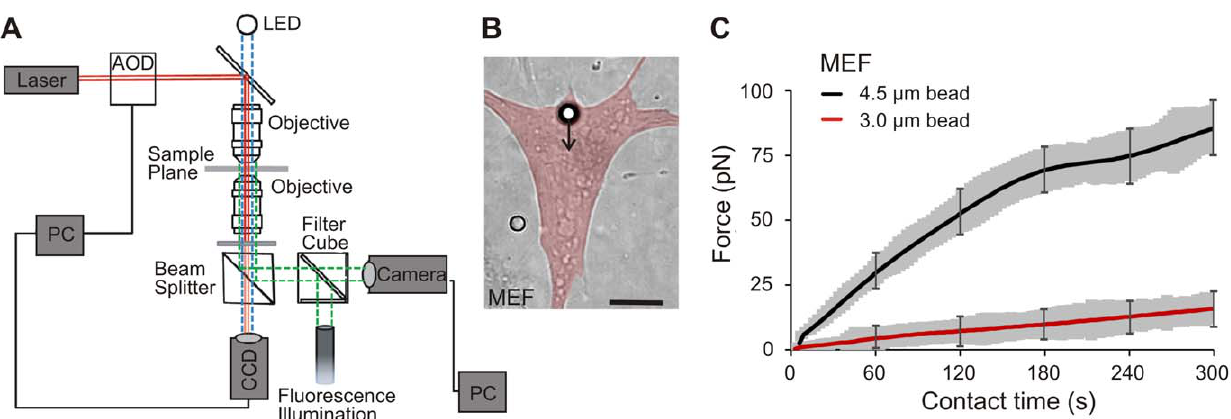
Figure 1. Experimental setup and cellular traction forces with regard to bead size. A) Schematic illustration of the multiple trap optical tweezers setup. The orthogonal alignment of two acousto-optic deflectors (AODs) allows for the simultaneous operation of several optical traps used to apply fibronectin functionalized beads to the cells. B) A fibronectin functionalized bead (3 m m diameter) is positioned by an optical trap in the leading edge of a cell. The arrow denotes the direction and magnitude of cellular traction forces. (a pseudocolored overlay was added to highlight the outline of the cell; scale bar=5 m m). C) Beads with a diameter of 3 m m and 4.5 m m, respectively, were aligned on the cellular leading edge. The obtained averaged force-time curves only show reinforcement over the entire measurement intervall for 4.5 m m beads. No reinforcement occurs at cell contact sites established at 3 m m beads (mean 6 s.e.m marked in gray and only exemplified for selected time points; N=5, n=14–17).